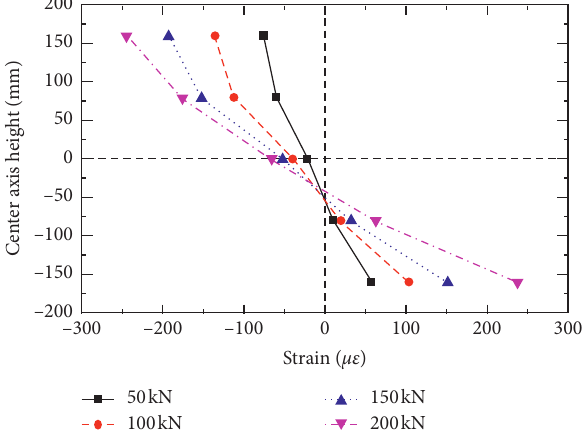
Figure 10: Concrete strain along the cross section.